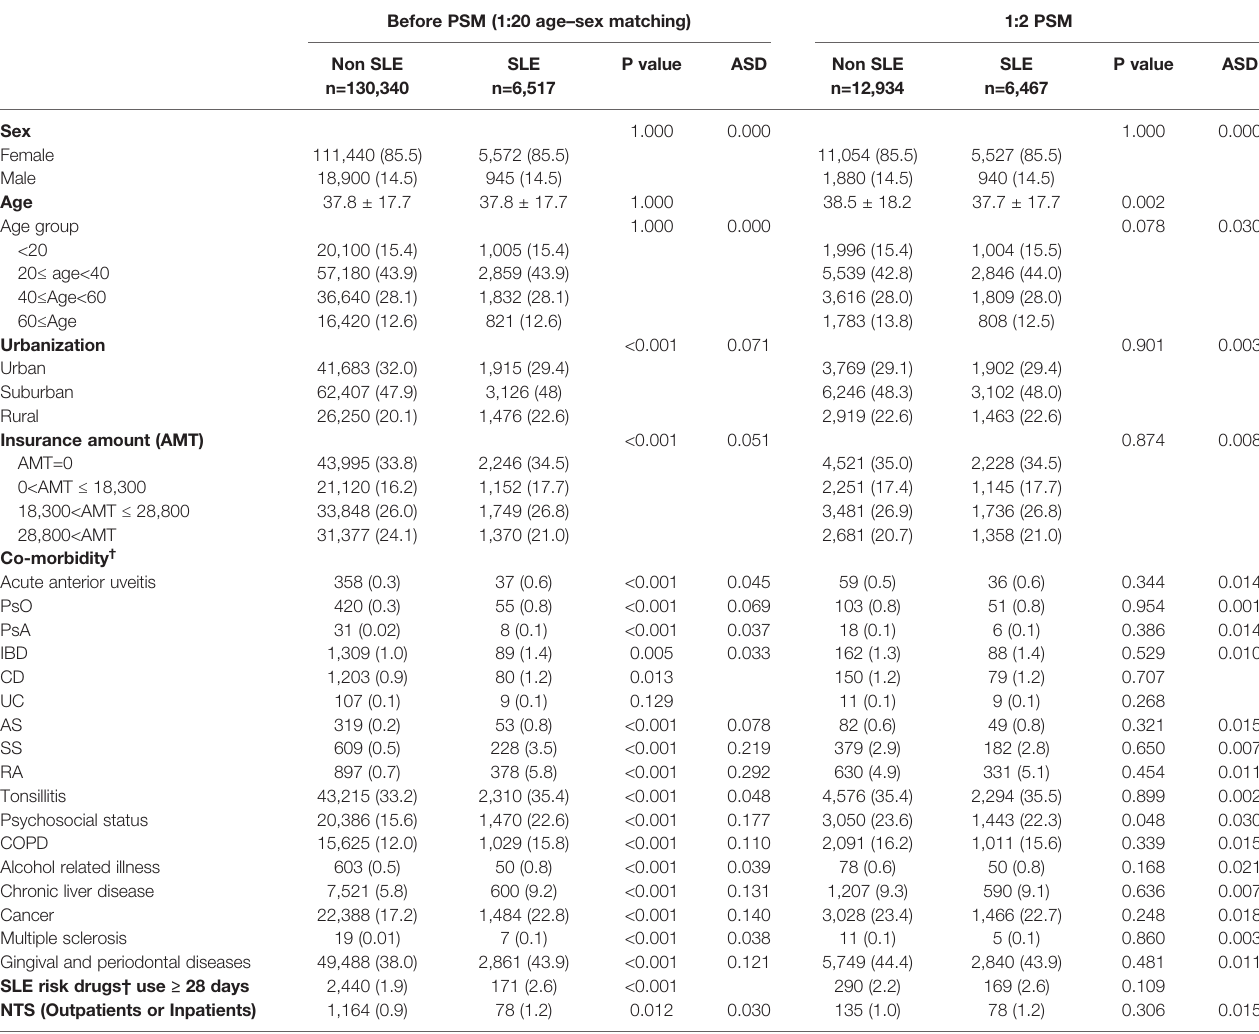
TABLE 1 | Baseline characteristics among SLE group and non- SLE group. Before PSM (1:20 age – sex